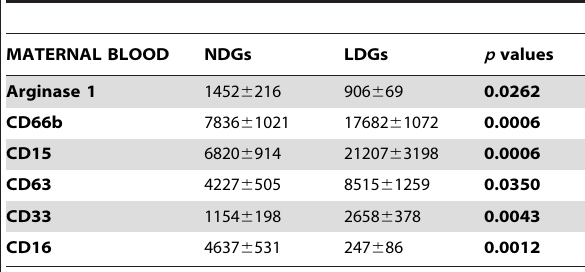
Table 2. Expression levels of arginase and phenotypic markers of NDGs and LDGs in maternal peripheral blood.